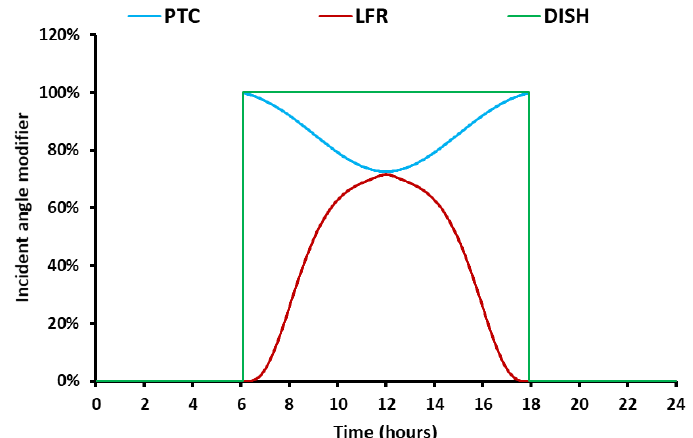
Figure 3. Daily variation of the incident angle modifier for the three collectors in June. PTC: parabolic trough collector; LFR: Linear Fresnel reflector; DISH: Solar dish.